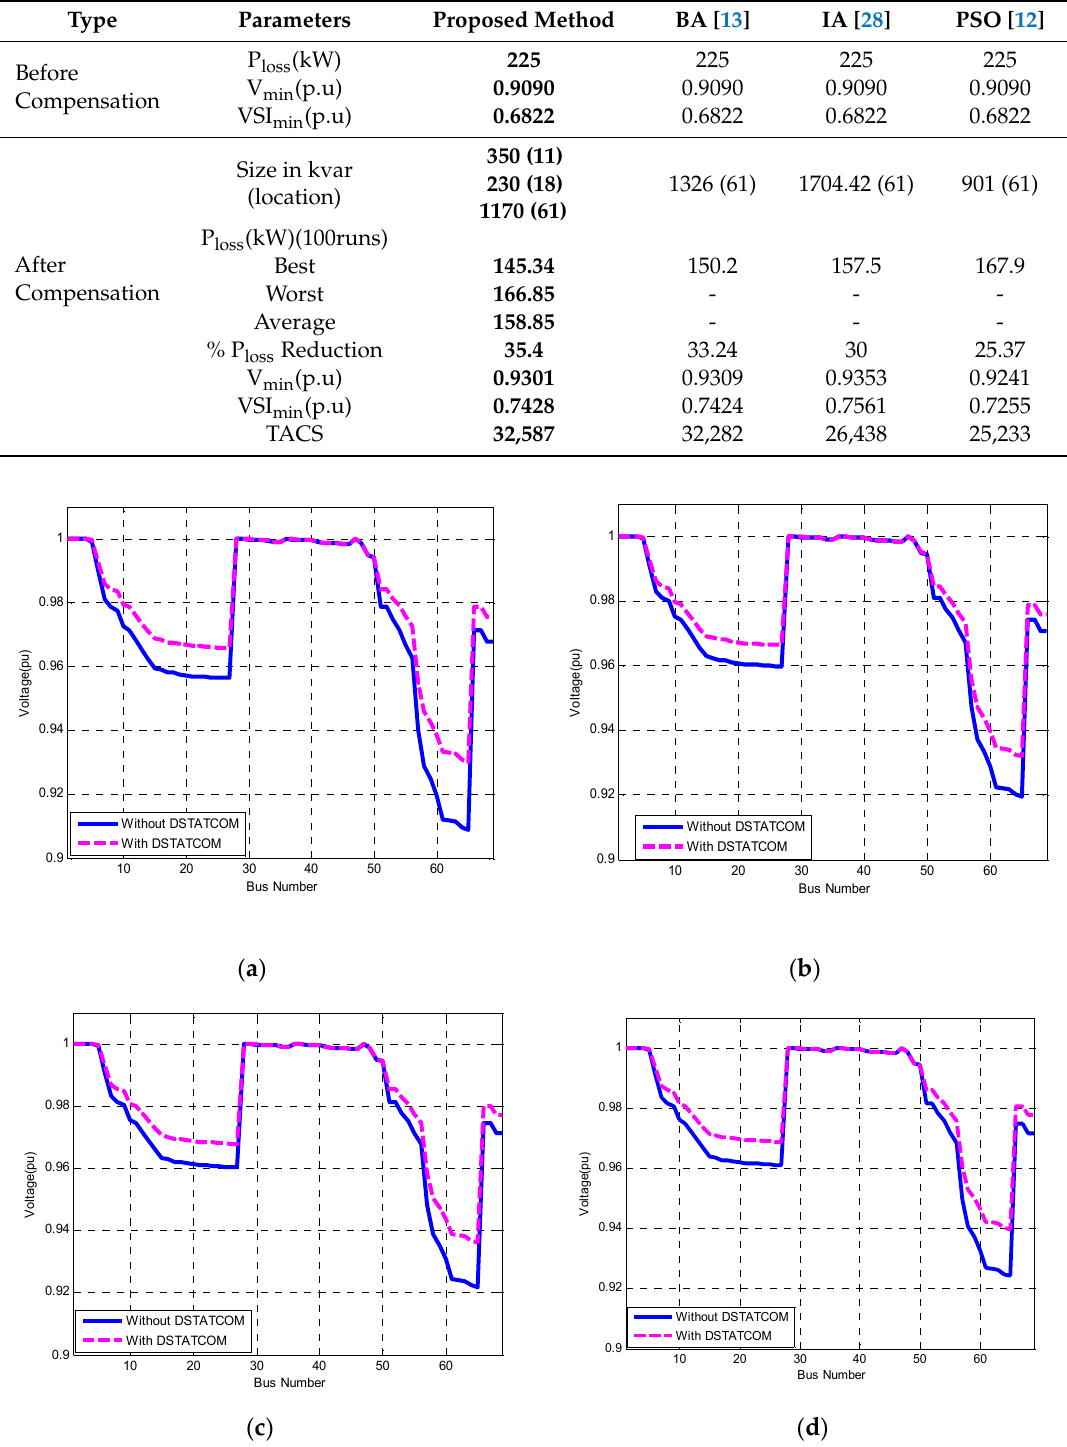
Figure 8. Voltage profile of standard 69-bus test system under di ff erent load models: ( a ) Constant Load. ( b ) Industrial Load. ( c ) Residential Load. ( d ) Commercial Load.